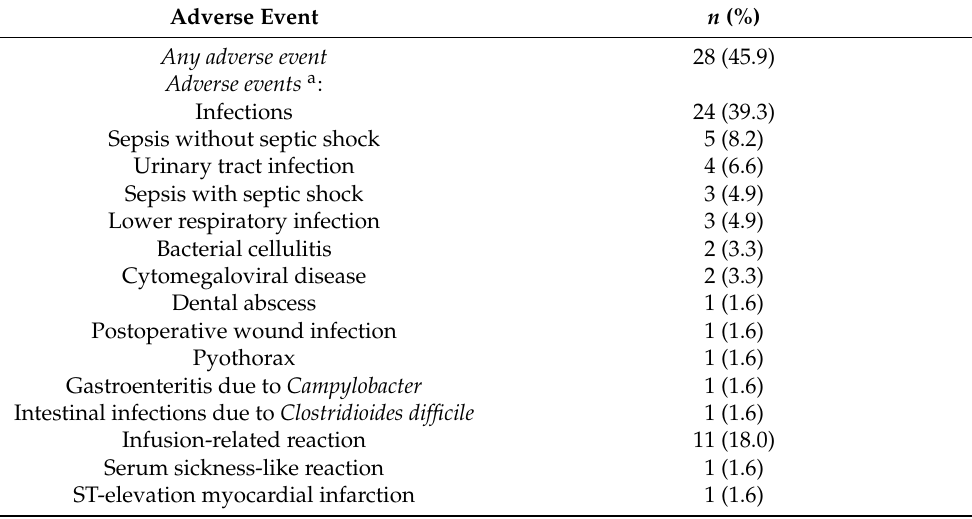
Table 5. Summary of adverse